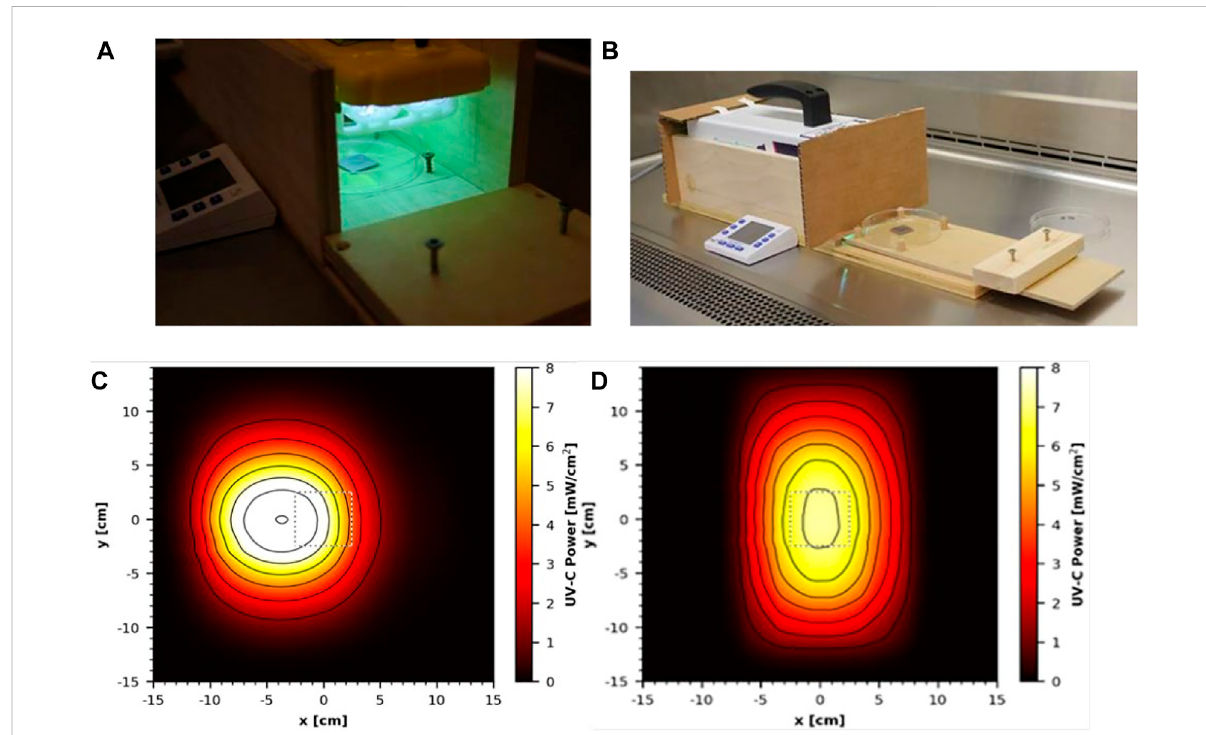
FIGURE 3 Testing setup and UV coverage for 18 and 35 W handheld devices. (A) GermAwayUV 18 W handheld device and custom test chamber shown during coupon exposure. (B) GermAwayUV 35 W handheld device and custom test chamber, shown in the pre/post exposure state. (C,D) UV coverage heat maps for the 18 W device (C) and the 35 W device (D) taken 5 cm from the